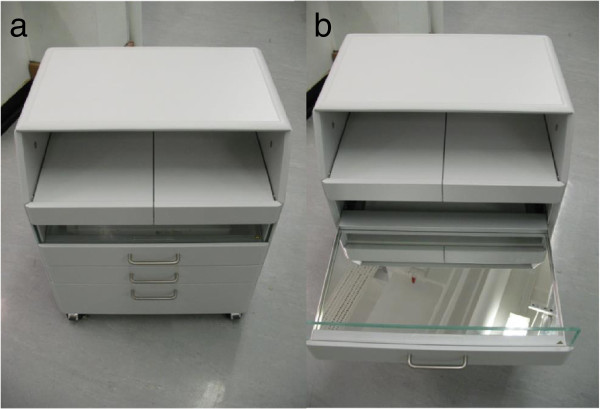
UV podiatry cabinet, UV Drawer closed (a) and open (b).